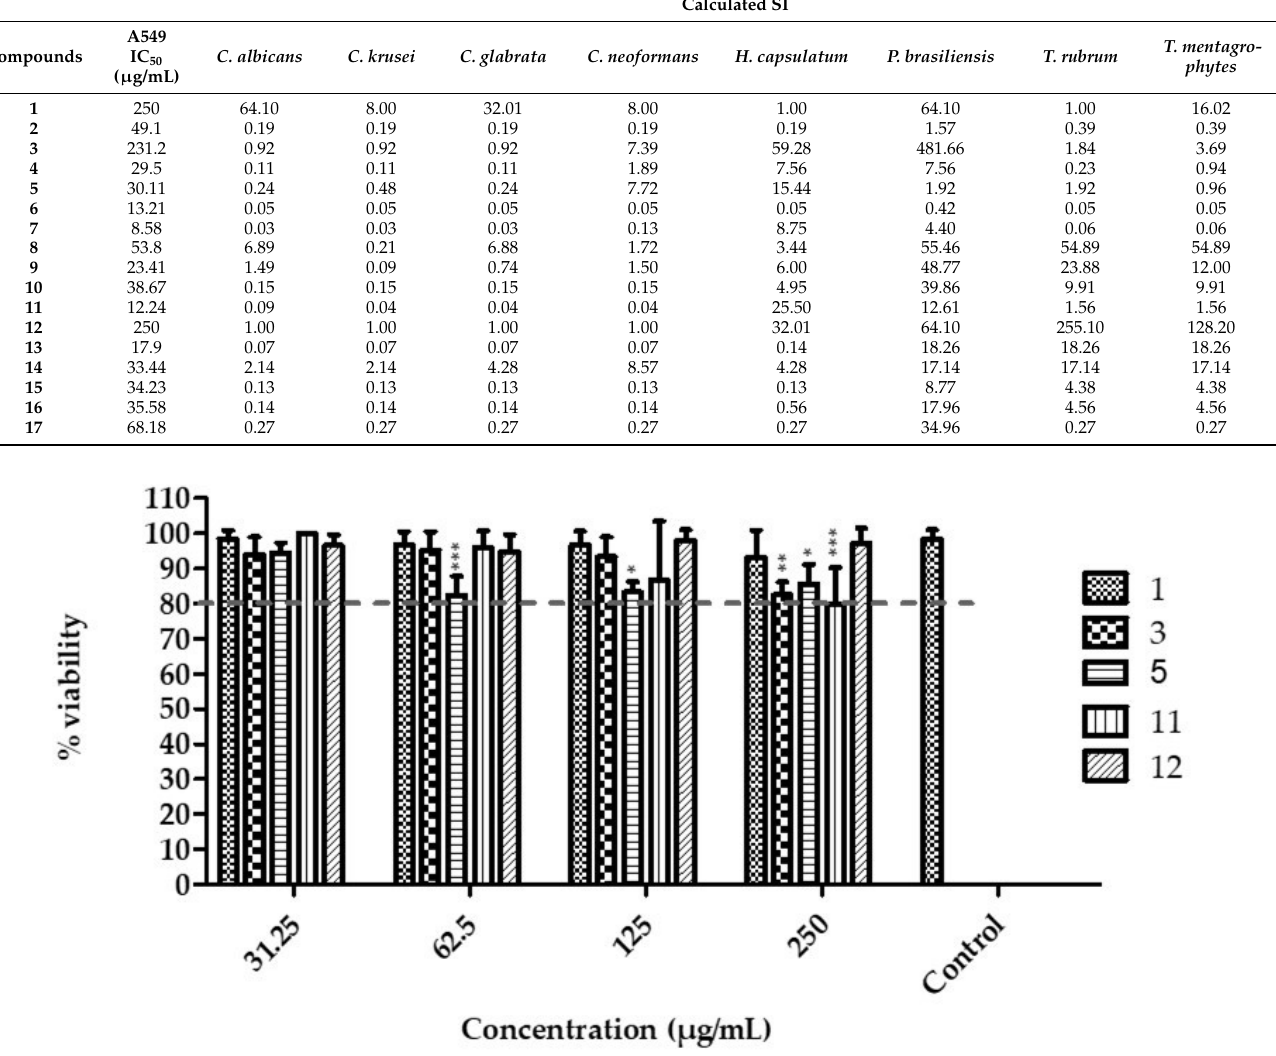
Figure 4. Images of L4 stage Caenorhabtis elegans : 32 larvae at a compound concentration equal to 250 µg/mL. ( A )—control group, the black arrow indicates a live larva, in its sinusoidal form; ( B – F )— representative images of compounds 1 , 3 , 5 , 11, and 12 , respectively; the black arrows point to a live larva in its characteristic shape (sinusoidal) and the orange arrow shows a dead larva in its characteristic rod shape. 4. Discussion Fungal diseases can affect the oral mucosa, skin, nails, hair, lungs, brain, or several organs and tissues simultaneously [6,18,19,24,25,35]. Constant global changes and the